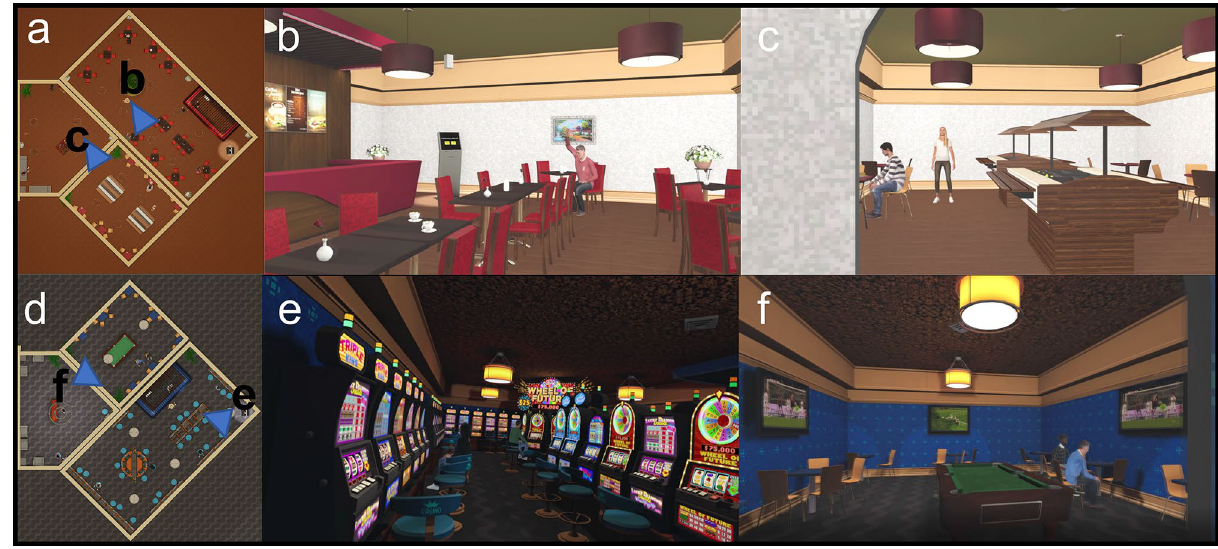
Figure 1. Experimental areas of the VR-environments. ( a ) Floorplan of the café within the VR-neutral environment. ( b ) View of the main room of the café. ( c ) View of the buffet area of the café. ( d ) Floorplan of the casino within the VR-gambling environment. ( e ) View of the main room of the casino. ( f ) View of the sports bar within the